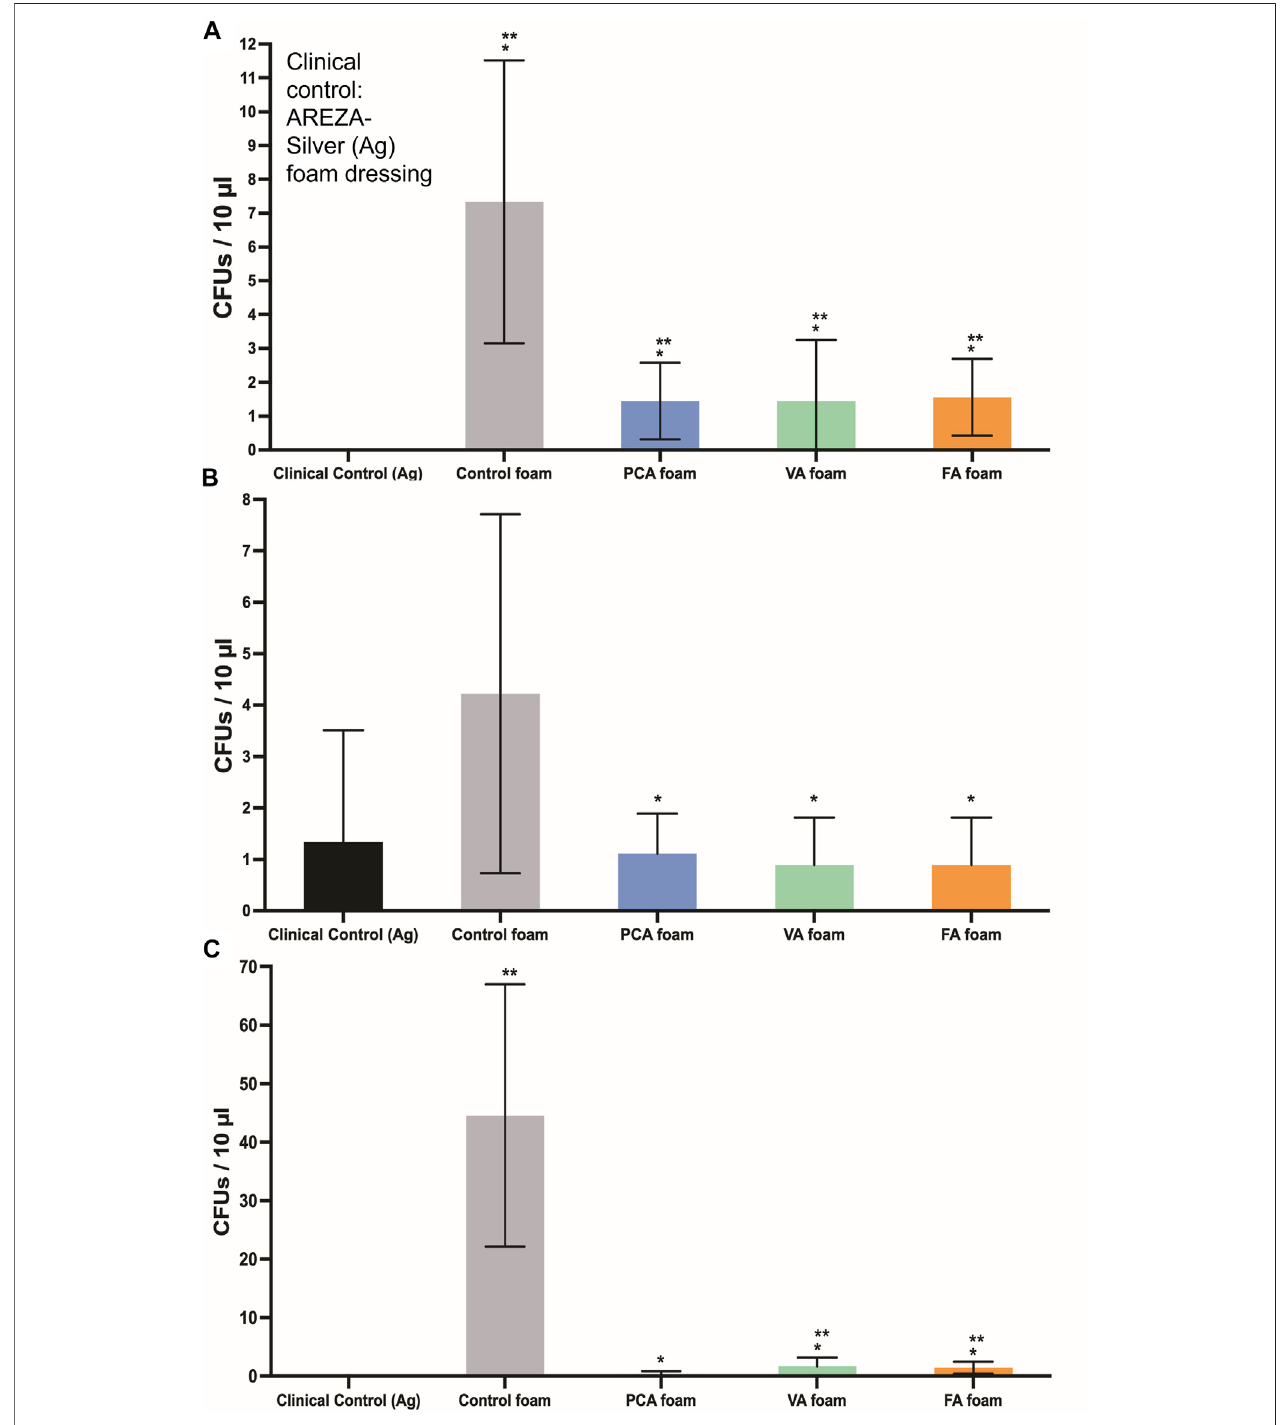
FIGURE 7 | CFU densities of bacteria after incubation with SMP foams. (A) E. coli, (B) S. aureus , and (C) S. epidermidis . Clinical control: AREZA Medical-silver based foam dressings. n = 9, mean ± standard deviation displayed, * p < 0.05 relative to the control foam; ** p < 0.05 relative to the clinical control.